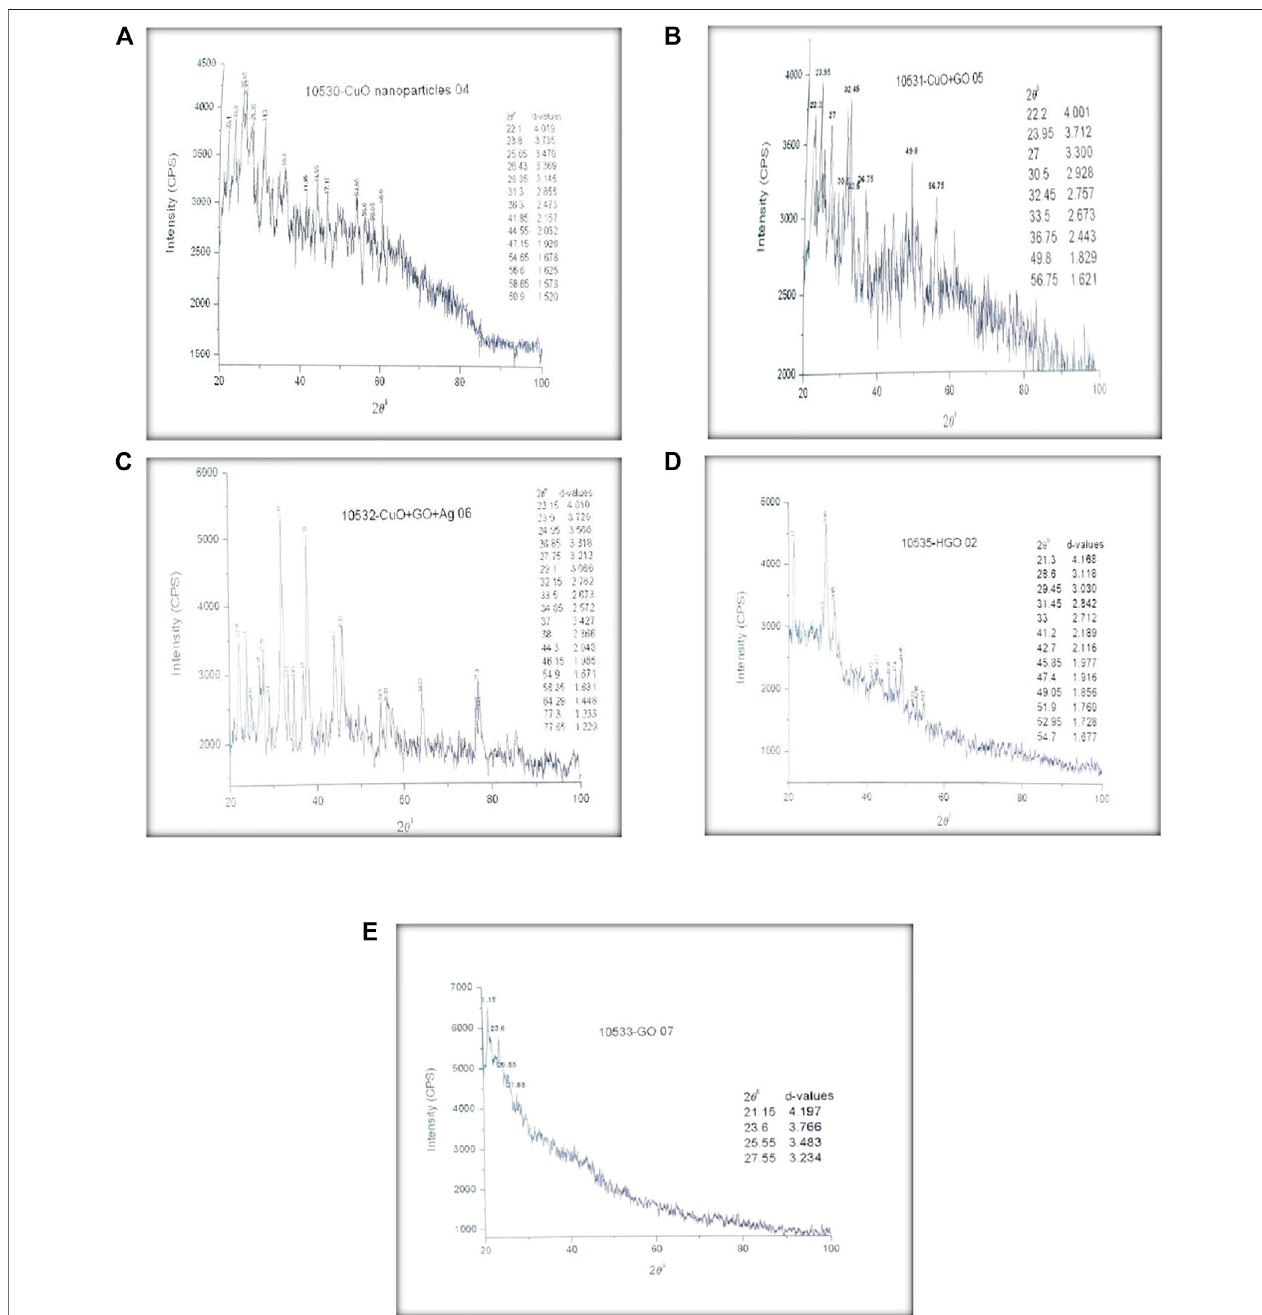
FIGURE 6 | (A) XRD Results of CuO NPs (B) XRD Results of CuO-GO (C) XRD results of CuO-GO-Ag nanocomposite (D) XRD Results of GO synthesized by Hummers method (E) XRD Results of GO synthesized by Hydrothermal approach.